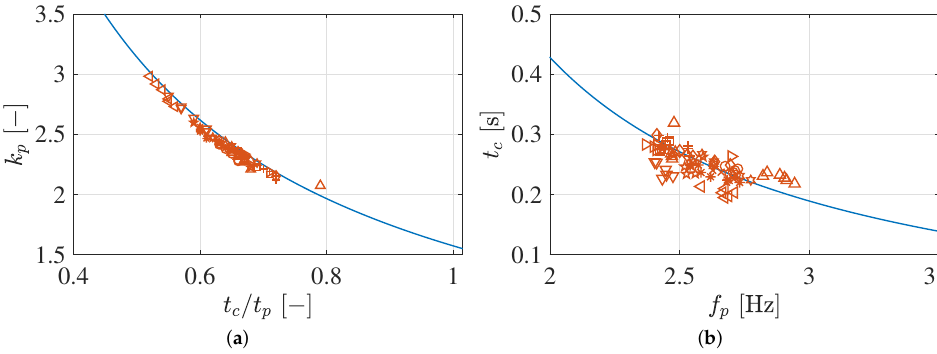
Figure 6. ( a ) The impact factor k p in terms of the ratio t c / t p : following Equation (4) (solid) and optimal fit for each test (symbol); ( b ) The contact time t c in terms of the pacing rate f p : following Equation (3) (solid) and optimal fit for each test (symbol). A different symbol is used for each participant.